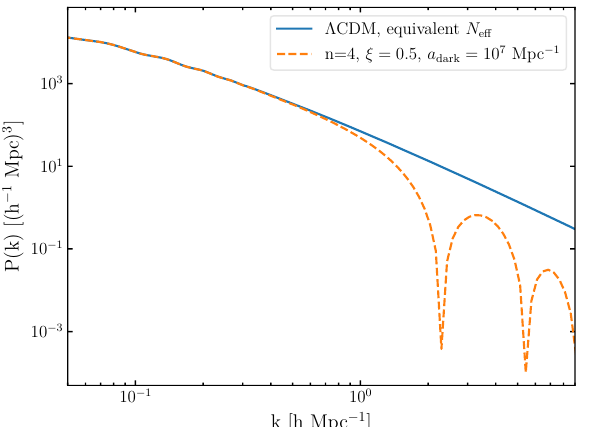
Figure 6. Matter power spectrum for Λ CDM (blue solid line) with the same N eff as in the interacting dark matter–dark radiation case (orange dashed line), where the amount of dark radiation is defined by the temperature ratio ξ = T DR / T γ = 0.5. The index n denotes the temperature dependence of the comoving interaction rate, while the parameter a dark represents the strength of the interaction; in order to show the impact of the interactions, we chose a value of a dark much larger than the current limits. The plot is made with the CLASS version publicly released with